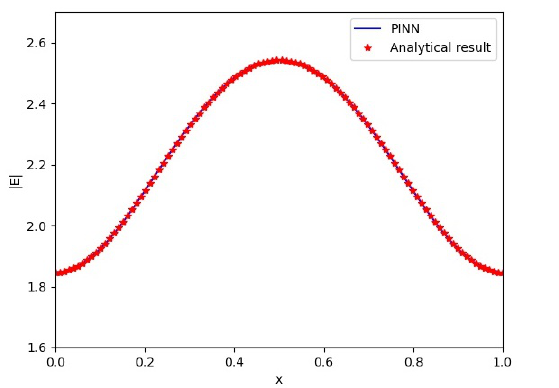
Figure 8. ( a ) The mesh diagram of the model; ( b ) the gradient modulus comparison between the first-order FEM and the analytical result.